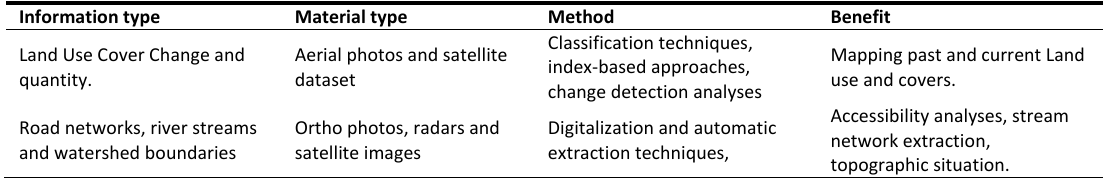
Table 1 Benefits of RS tools in spatial planning (adopted from Şatır et al ., 2022). Information